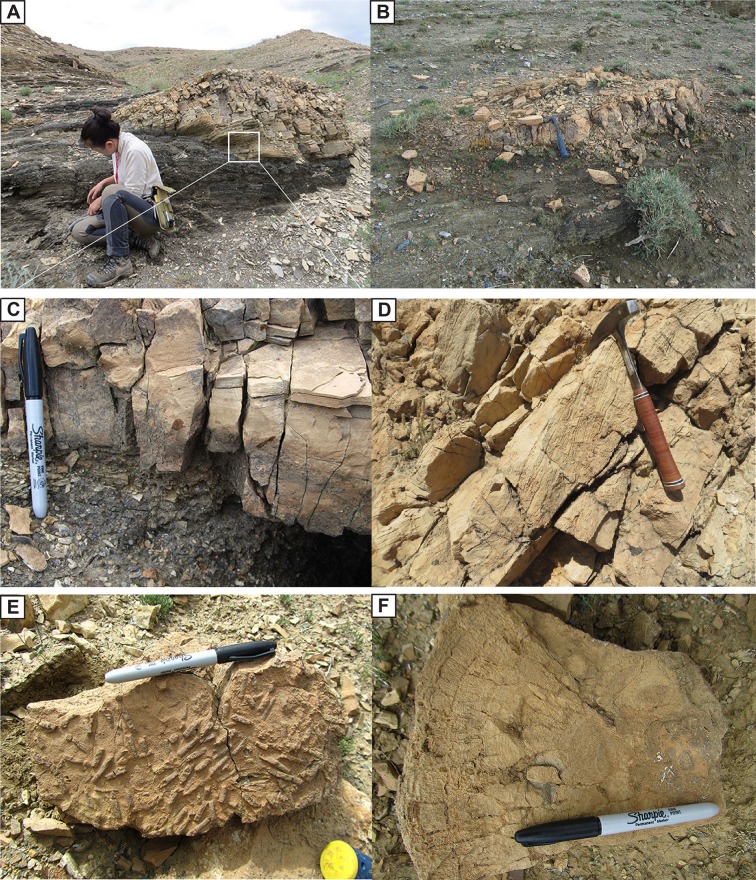
Photos of the bioherms.(A) Mound-shaped bioherm bounded by laminated, organic-rich mudstone. (B) Mound-shaped bioherm bounded by laminated mudstone. (C) Contact between bioherm and underlying mudstone. (D) Wavy laminated structure of the bioherm. (E) Tube-shaped caddisfly cases on the weathered surface of bioherm. (F) Fine laminated internal structure of the bioherm.